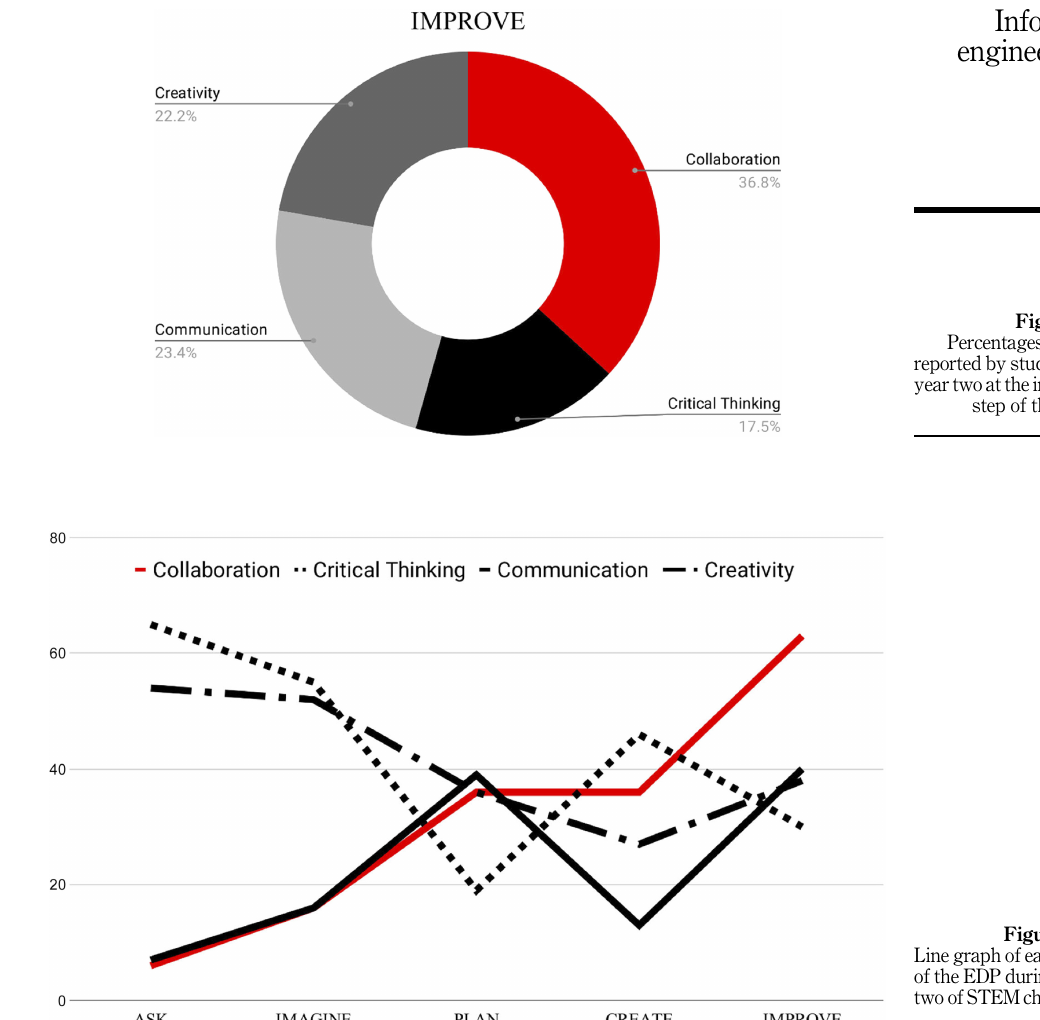
Figure 10. Line graph of each